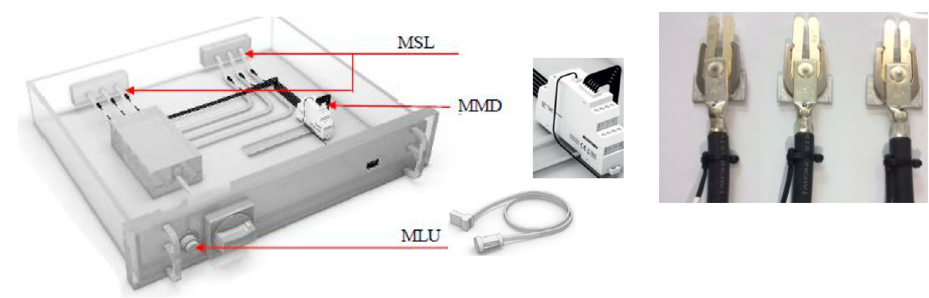
Figure 6. Temperature monitoring in pull-out modules; MMD (MCC Modbus Datacard); MSL (MMC Sensor Loom); MLU (MCC LED).